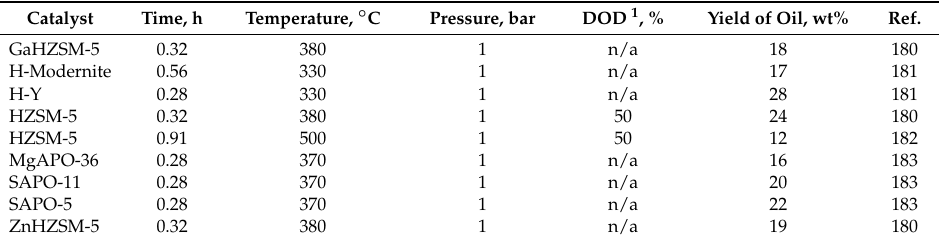
Table 8. Review of the research for the catalytic vapor cracking of